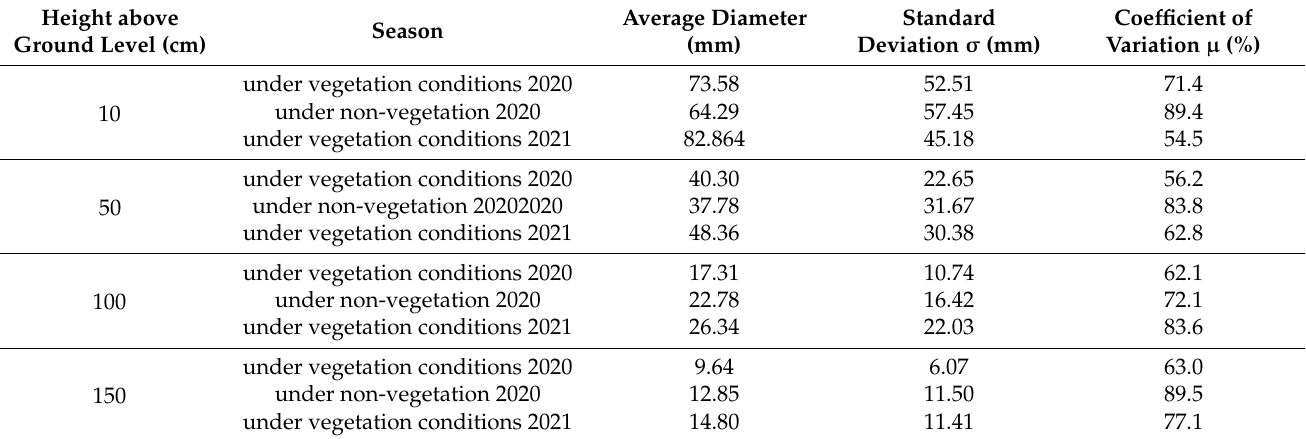
Table 3. Summary of the results of the series of measurements of the branches diameters of shrub No. 3.